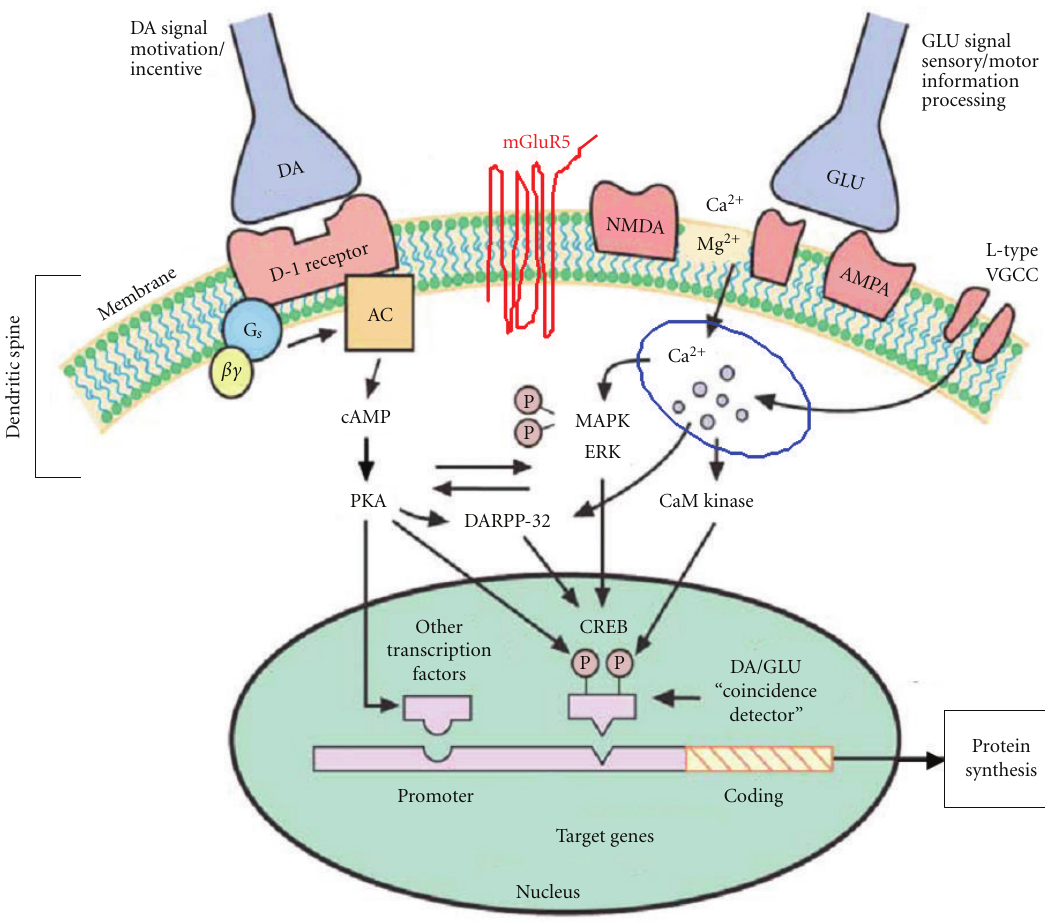
Figure 2: Colocalization of dopamine receptors and glutamate receptors leads to activation of intracellular transduction mechanisms, induction of regulatory transcription factors, and ultimately long-term changes in cellular plasticity in the hippocampus. AC: adenylyl cyclase, AMPA: α -amino-3-hydroxy-5-methyl-4 isoxazolepropionic acid receptor, CREB: cAMP-response element binding protein, DA:dopamine, DARPP-32: Dopamine, cAMP-regulated phosphoprotein of 32,000 kDa, ERK: extracellular signal-regulated kinase, GLU: glutamate, GluR5:Metabolic glutamate receptor type 5, MAPK: mitogen-activated protein kinase, NMDA: N-methyl d-aspartate receptor, PKA: protein kinase A, VGCC: voltage-gated calcium channel. (Adopted and modified from